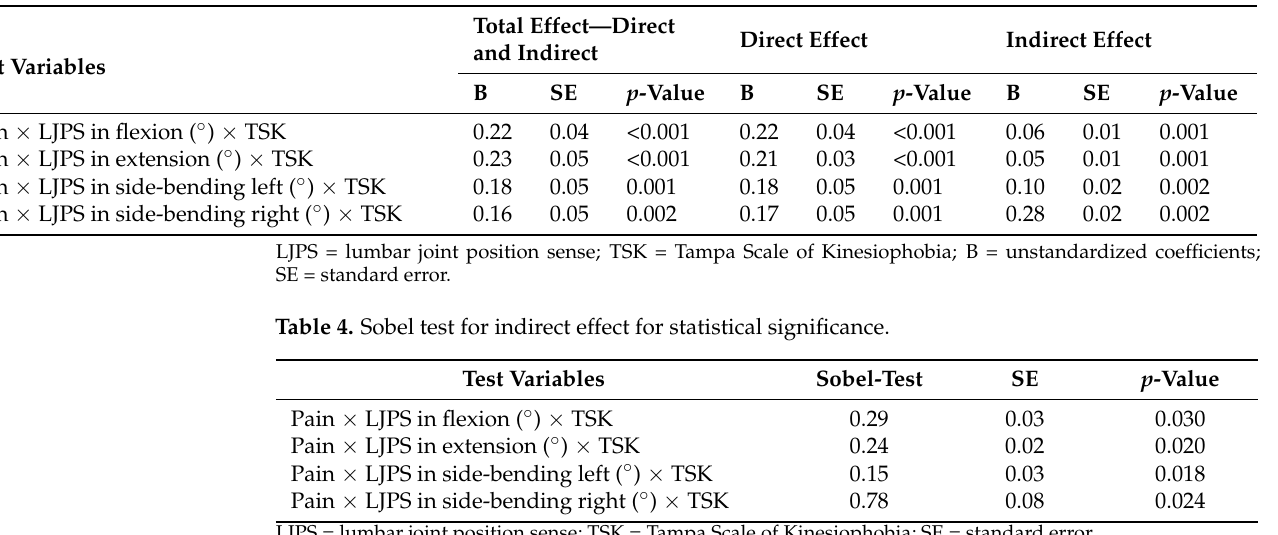
Table 3. Mediation analysis of the association between kinesiophobia and lumbar JPS.